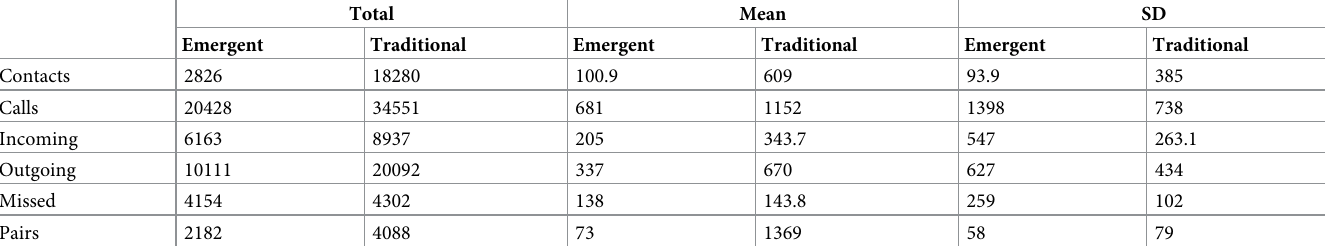
Table 3. Summary of main features of emergent and traditional users’ call logs and contact-books. Emergent users had a mean number of 100.9 (s.d 94) contacts which is quite low as compared to traditional users’ mean contacts i.e. 609 (s.d 385). The mean number of outgoing calls i.e. 337 (s.d 627) of emergent users was almost half of the traditional users’ mean number of outgoing calls i.e. 670 (s.d 434). Similarly, emergent users’ had a lower mean number of user pairs i.e. 73 (s.d 53) as compared to that of traditional users i.e. 1369 (s.d